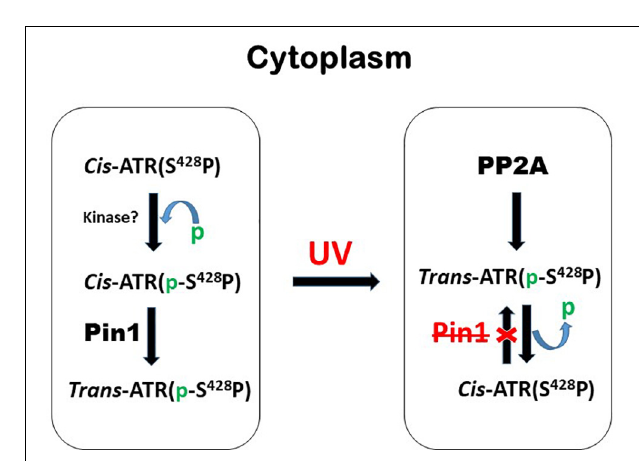
FIGURE 4 | A brief summary of the mechanism by which the levels of cytoplasmic cis - and trans -ATR isoforms are mediated by phosphorylation and dephosphorylation before and after UV irradiation. The red X stands for inhibition or inactivation of Pin1.